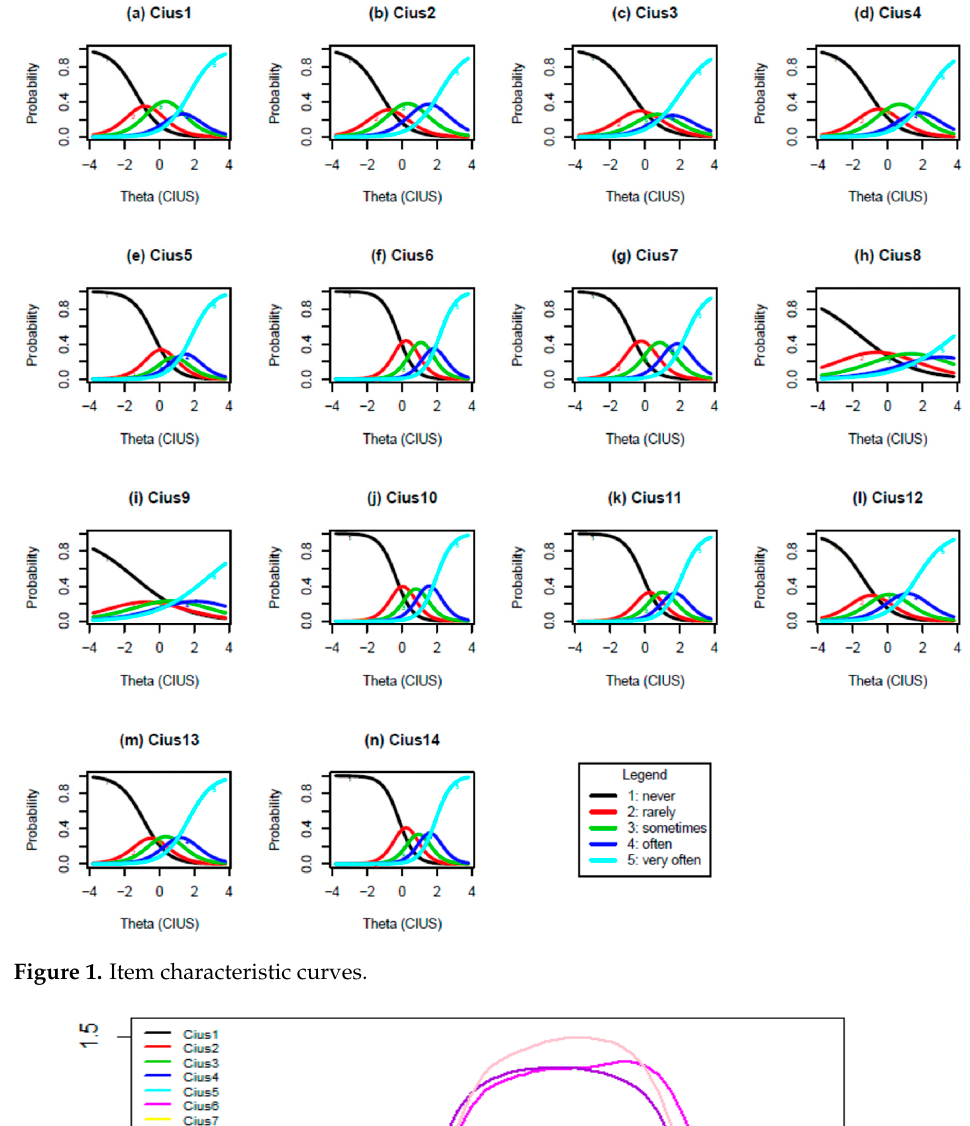
Figure 1. Item characteristic curves.